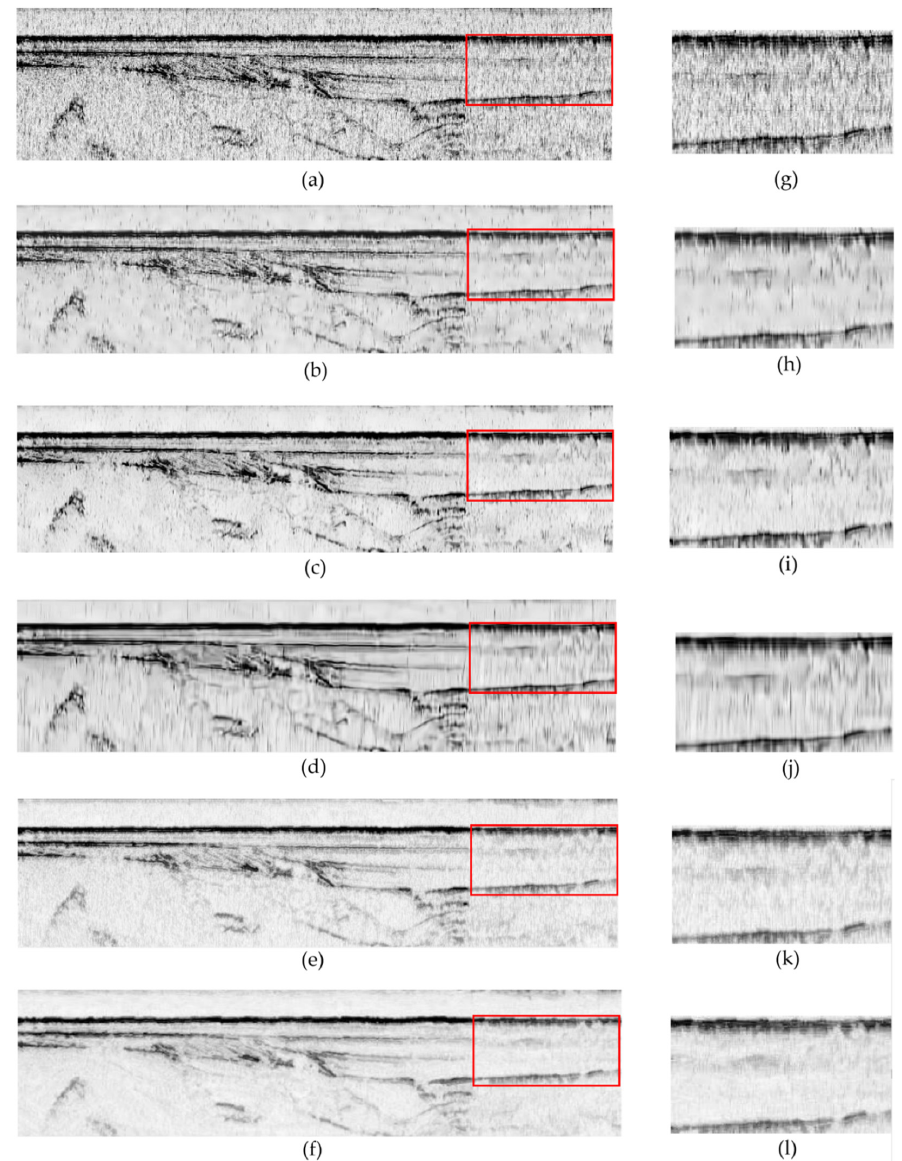
Figure 12. Filtering results: ( a ) is the SBP image, ( b – f ) are the filtered results using KSVD, NLM, BM3D, NLLR, and the proposed method, ( g ) shows the details of the SBP image in the rectangle area in Figure 12a, ( h – l ) are the filtered results in the rectangle area in Figure 12a using KSVD, NLM, BM3D, NLLR, and the proposed method.